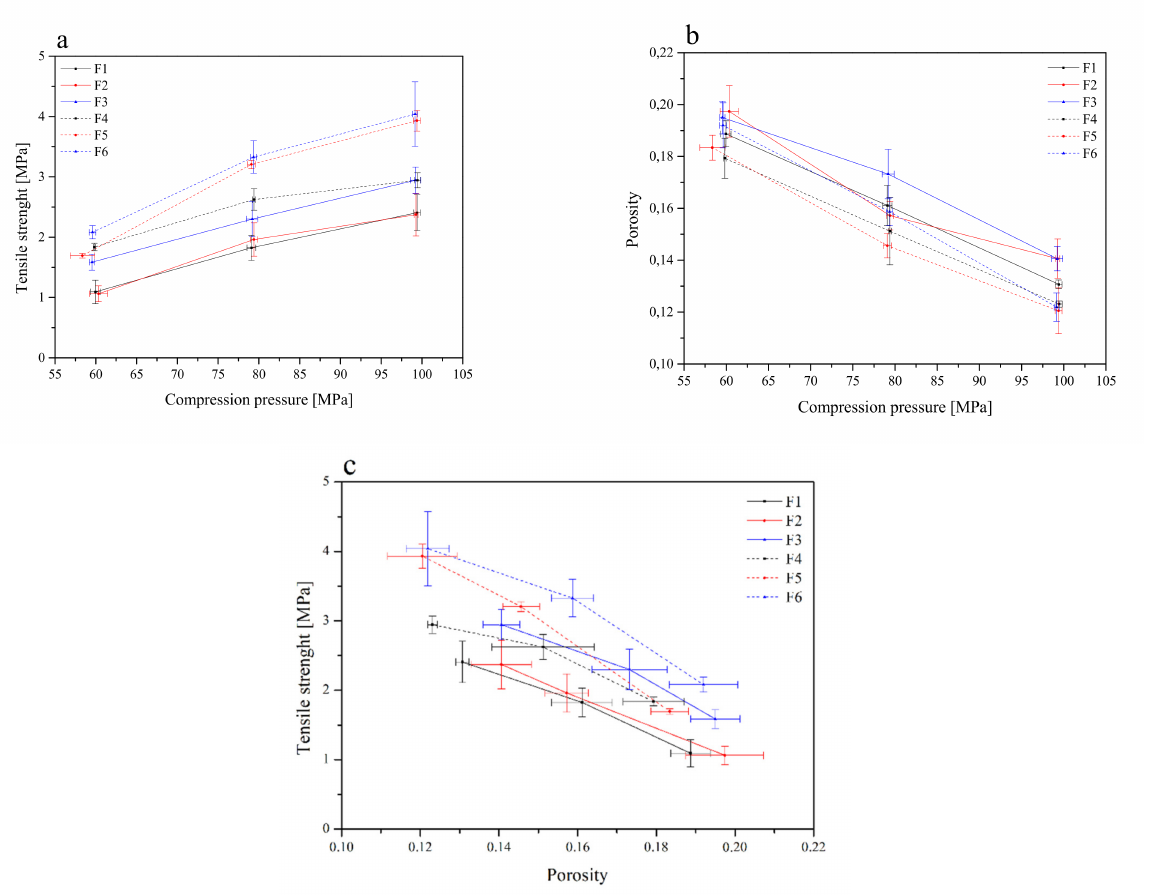
Figure 4. Tabletability ( a ), compressibility ( b ) and compactability ( c ) profiles of the tablets containing lyophilized cyclodextrin-based Polygoni cuspidati extract (formulations